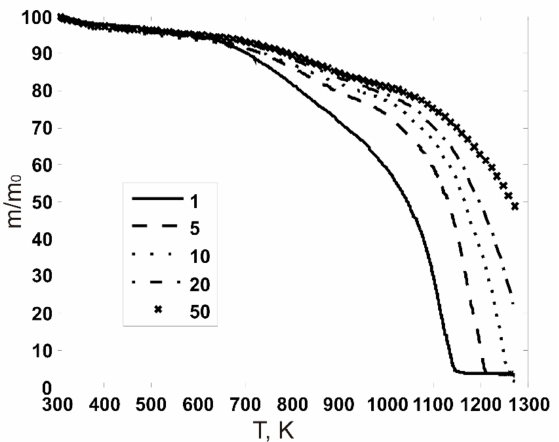
Figure 3. TG curves for charcoal gasification in the carbon dioxide atmosphere at different heating rates (1, 5, 10, 20, and 50 K min − 1